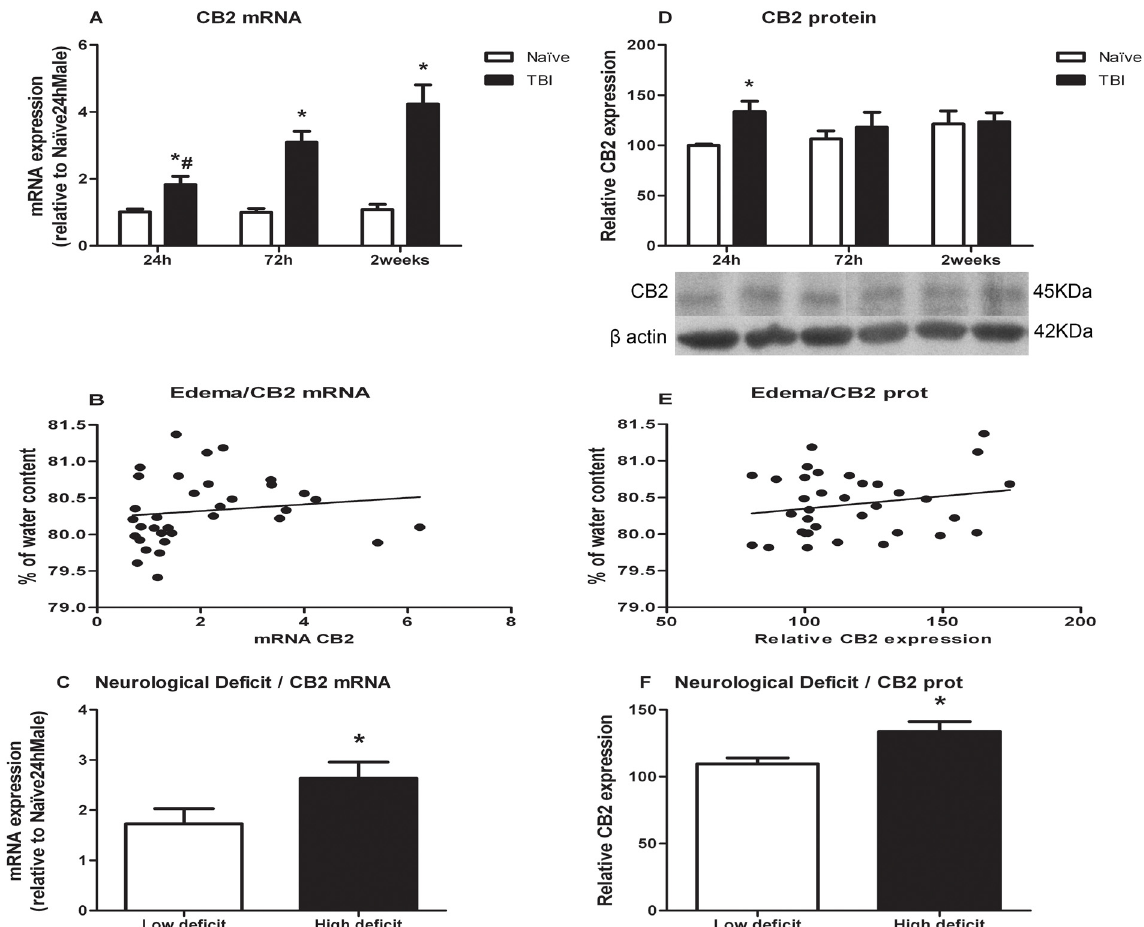
Fig 3. Effects of TBI on CB2 mRNA and protein levels. A) CB2 mRNA levels. B) Analysis of correlation between brain edema and CB2 mRNA levels. C) CB2 mRNA levels in animals classified according to neurological score. D) CB2 protein levels. E) Analysis of correlation between brain edema and CB2 protein levels. F) CB2 protein levels in animals classified according to neurological score. Data are mean ± SEM. * p < 0.05 versus na ï ve group of same time; # p < 0.05 versus two weeks of same